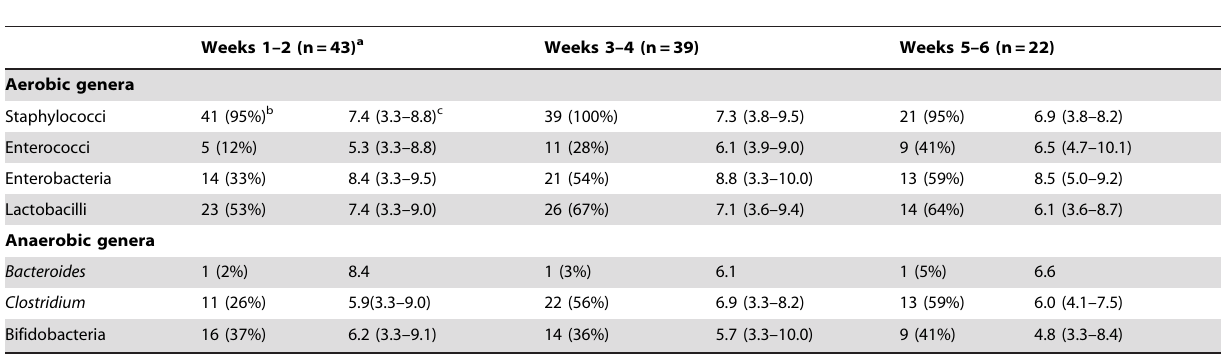
Table 1. Bacterial colonization in enrolled preterm infants from week 1 to week